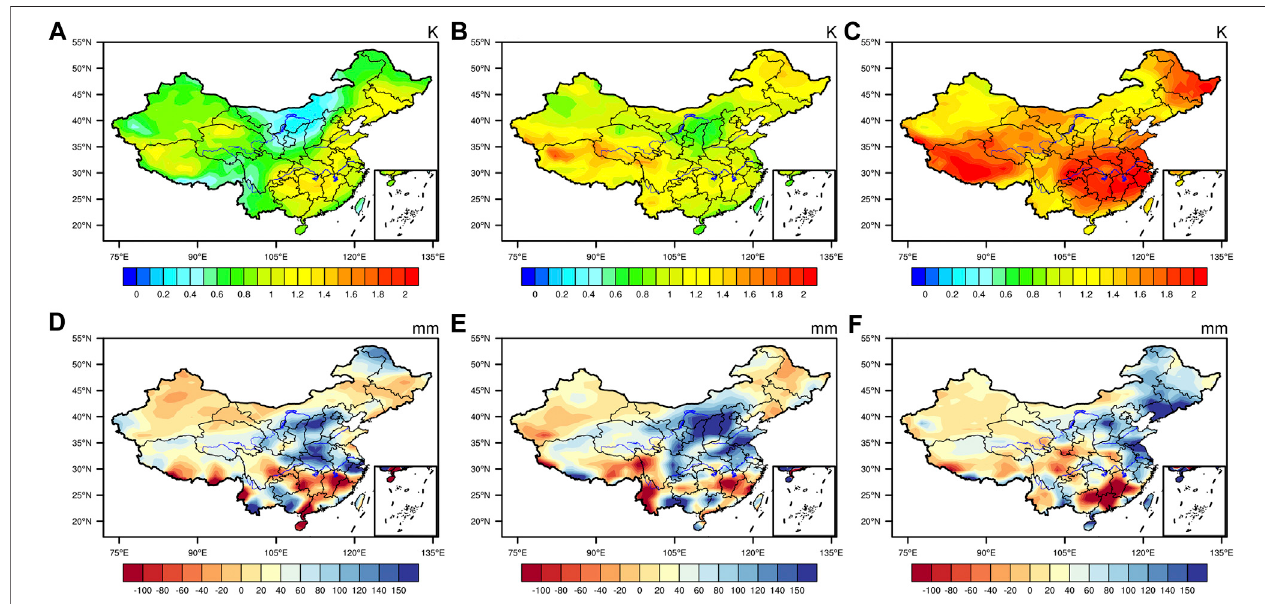
FIGURE 3 | Temperature and precipitation difference between 2050 and 2015 under different scenarios; (A) SSP1 – 2.6 temperature, (B) SSP2 – 4.5 temperature, (C) SSP5 – 8.5 temperature, (D) SSP1 – 2.6 precipitation, (E) SSP2 – 4.5 precipitation, and (F) SSP5 – 8.5 precipitation.